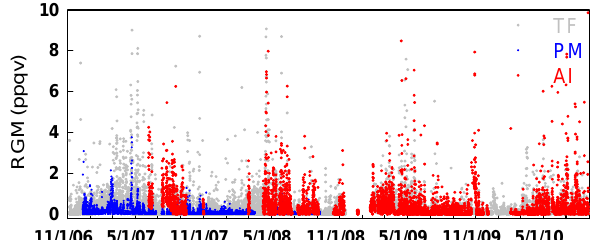
Figure 5. Complete time series of 2-hourly RGM mixing ratios at Thompson Fig. 5. Complete time series of 2-hourly RGM mixing ratios at Farm (TF), Pac Monadnock (PM), and Appledore Island (AI). Thompson Farm (TF), Pac Monadnock (PM), and Appledore Island